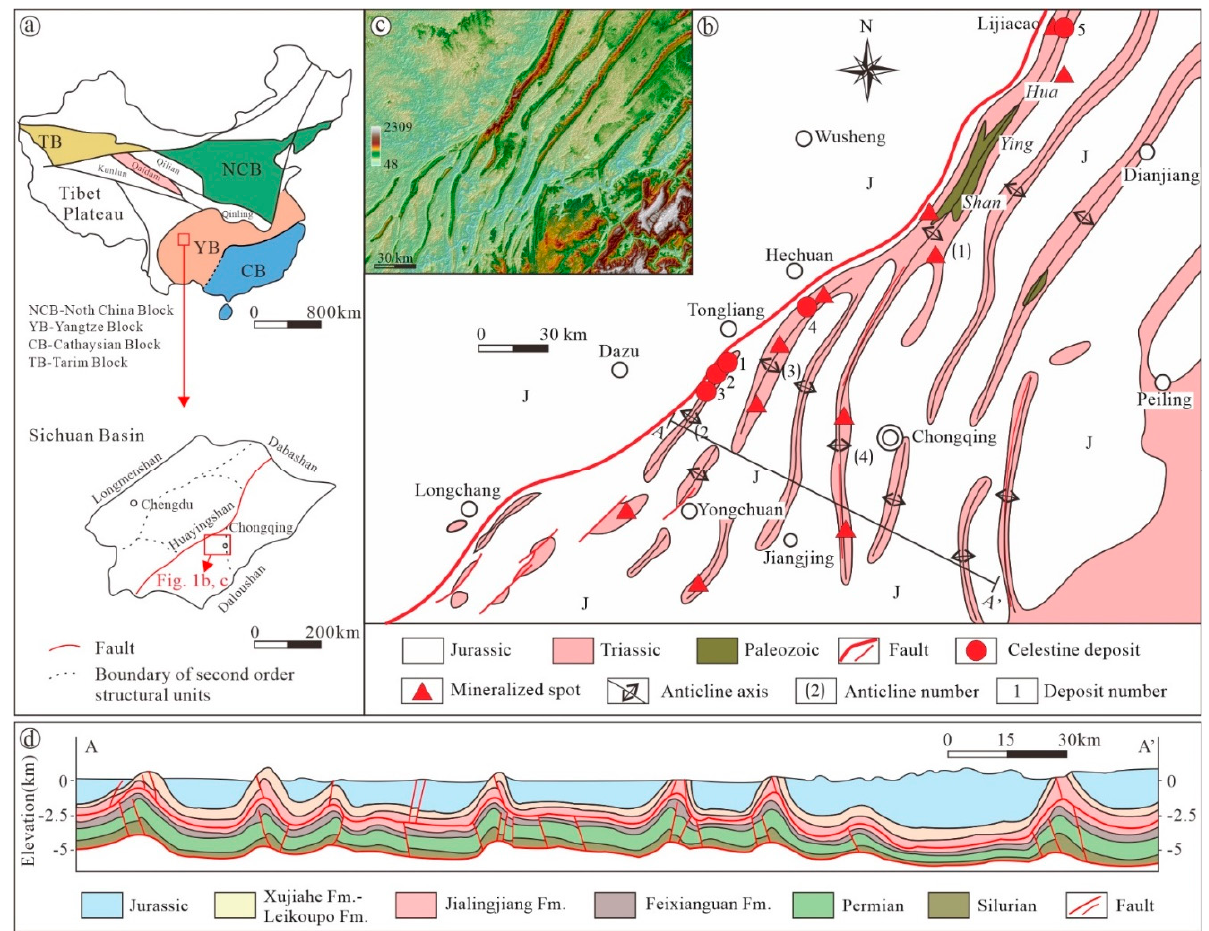
Figure 1. ( a ) Simplified tectonic map of part of China and the Sichuan basin (modified from [46,54]), showing the location of the study area. ( b ) Regional geological map of the Chongqing Sr metallogenic province, showing the distribution of the Sr deposits and mineralized spot (modified from [13]); 1—Yuxia, 2—Chenjiapo, 3—Xinglong, 4—Gangou, 5—Yangtianwo, (1)—Huayingshan, (2)—Xishan, (3)—Libixia, (4)—Guanyinxia. ( c ) DEM of the fold belt in the east of the Sichuan Basin, showing the geomorphic features of the fold belt. ( d ) Geological section through the fold belt in the east of the Sichuan Basin, showing the fault distribution (modified from [55]).